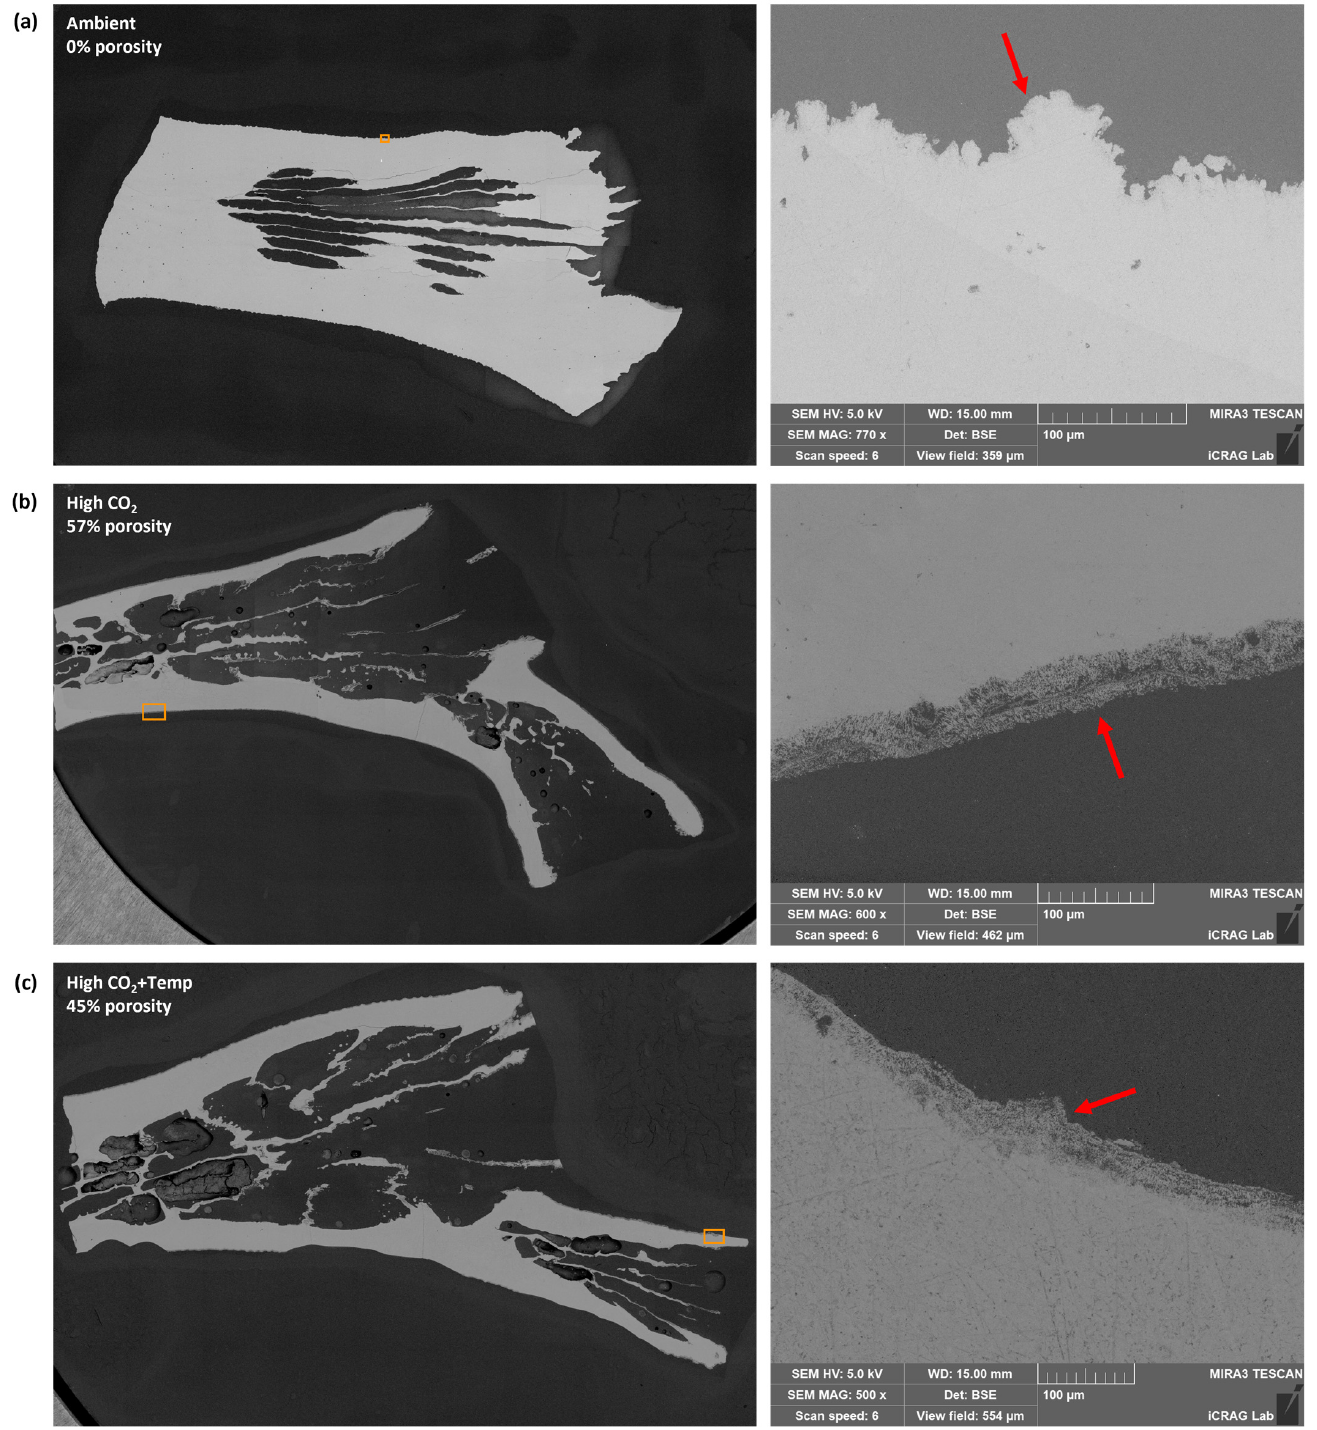
Figure 5. Scanning electron microscopy images for Desmophyllum pertusum samples showing visible material alterations of the outer coral walls for ( a ) ambient, ( b ) high CO 2, , and ( c ) high CO 2 +T samples. Full coral sample images are on the left and the orange inset boxes display zoomed images on the right. Red arrows represent the area of the outer wall where changes in porosity were calculated.